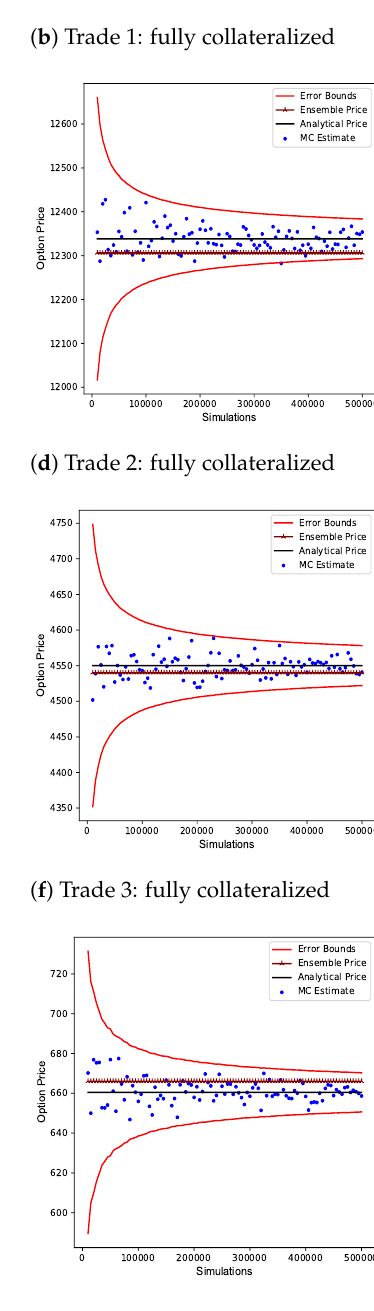
Figure 10. Comparison of